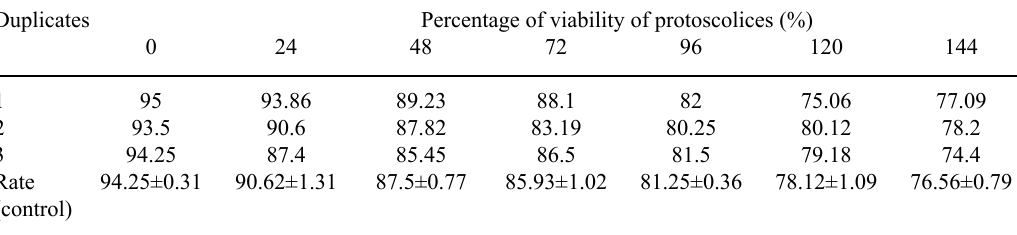
table 3. Determination of the percentage of protoscolices in 100 microliters within seven days